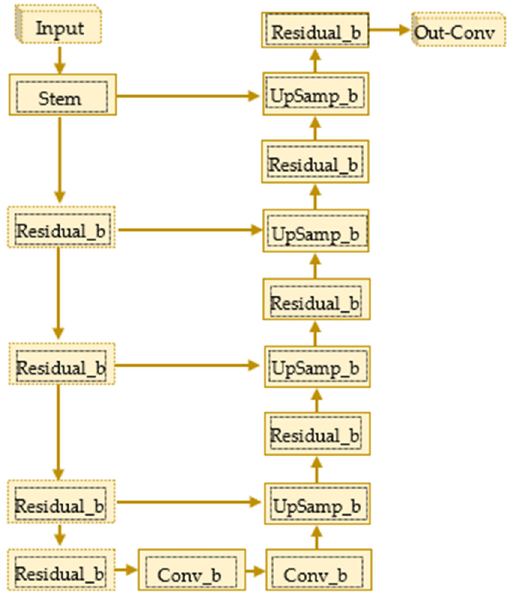
Figure 6. Visual representation of the proposed Res-U-Net.